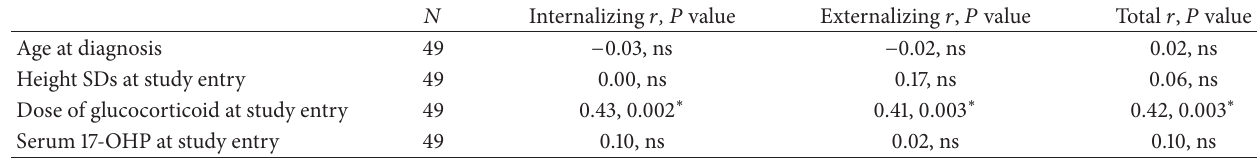
Table 8: Correlations between psychological adjustment and disease characteristics in CAH